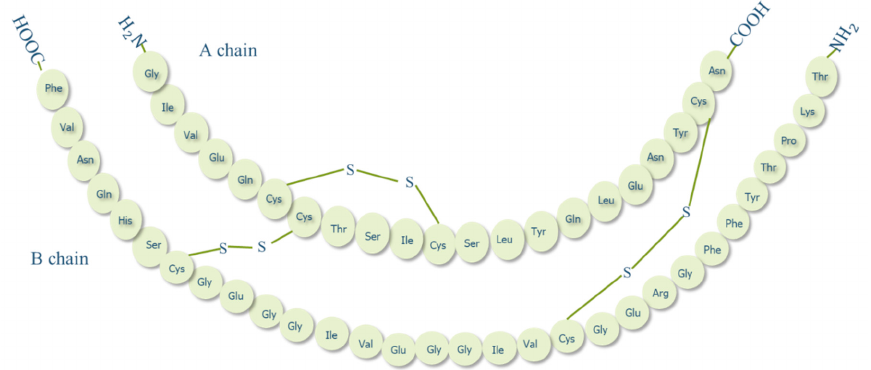
Figure 2. Structure of human insulin.